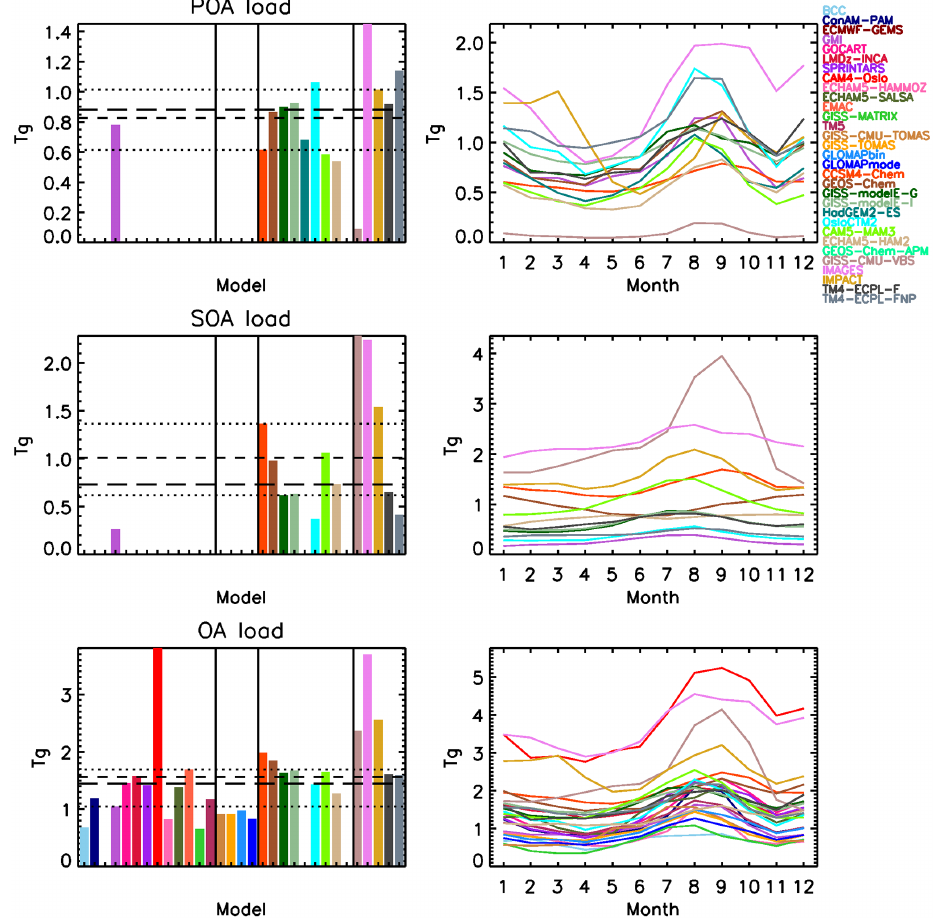
Figure 3. Same as in Fig. 2, for the POA/SOA/OA